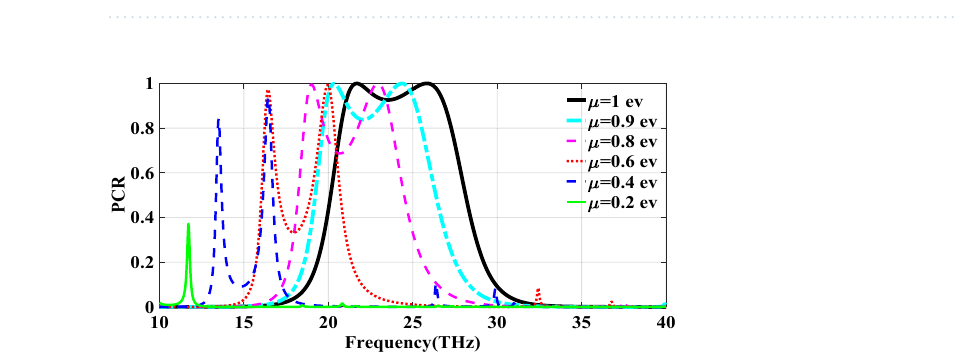
Figure 12. ( a ) Reflection coefficients of co and cross polarized reflected waves R xx and R xy , ( b ) PCR of the second structure.